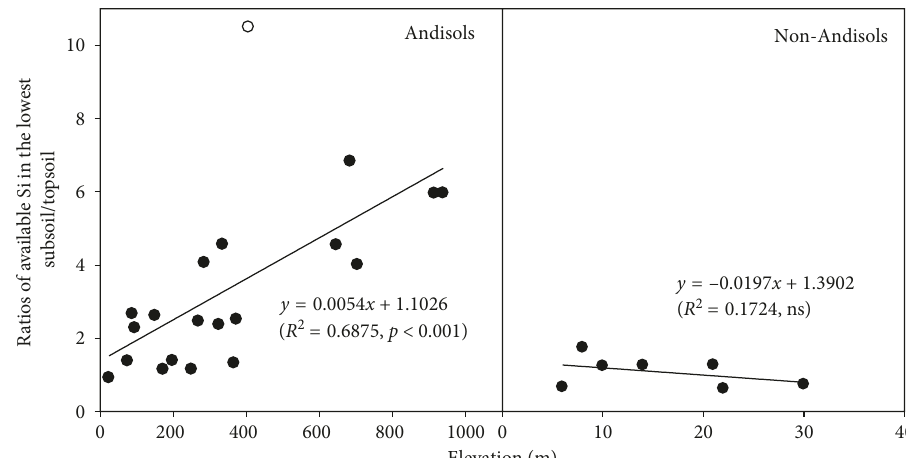
Figure 4: Correlation analysis of the relationship between elevation and ratio of available Si in the lowest subsoil/topsoil in the typifying pedons on Jeju Island. The open circle is excluded from the fitting.